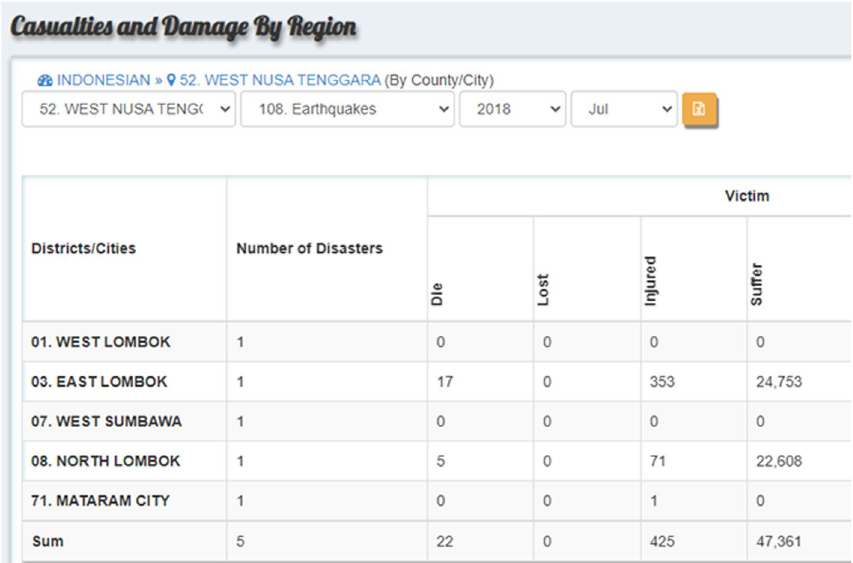
Fig. 6 A snapshot of the monthly natural disasters for all regions in Indonesia (Agency and (BNPB)